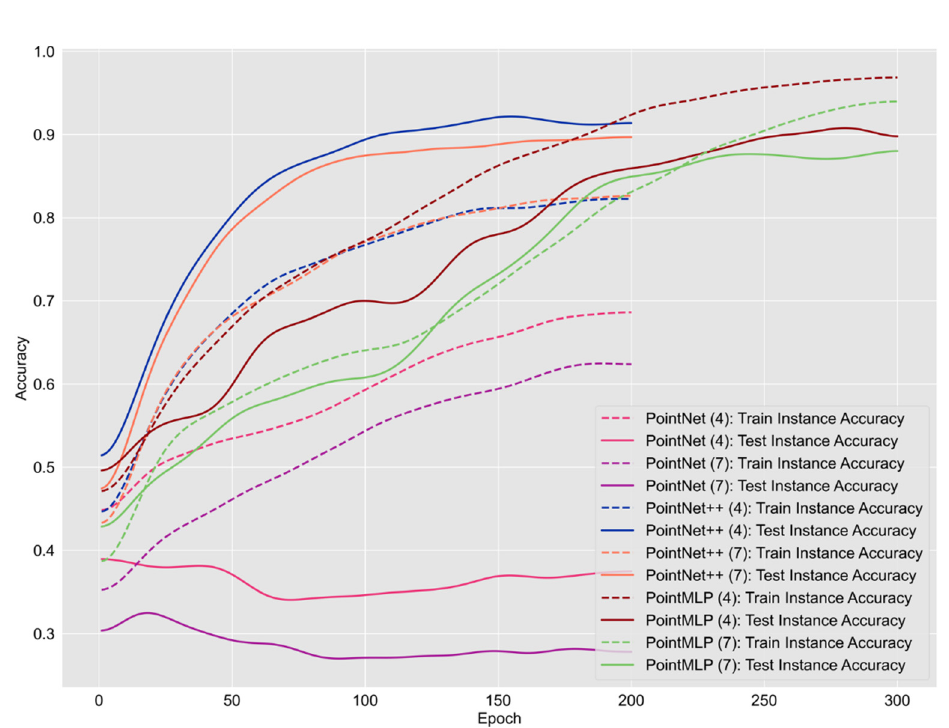
Figure 1. Instance accuracy during training of deep learning models (the curves were Gaussian smoothed, and the smoothing parameter was set to 10).